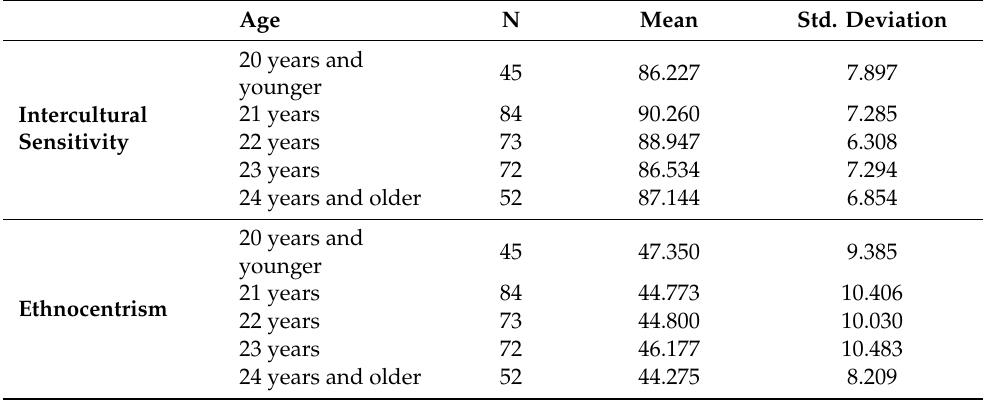
Table 6. Mean and standard deviation of students’ scores by age in the Intercultural Sensitivity and Ethnocentrism Scales. Age N Mean Std. Deviation